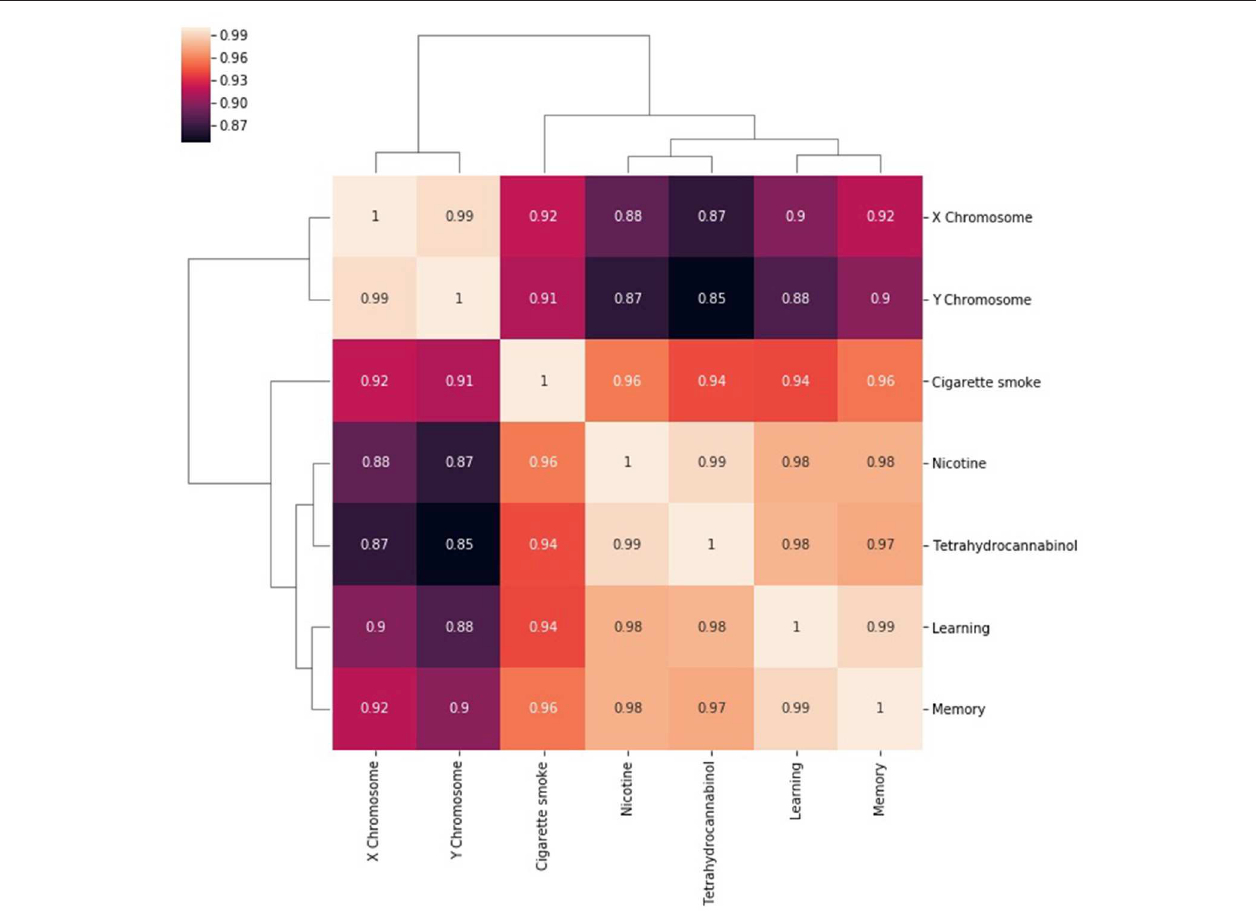
FIGURE 3 | A heatmap of the correlation between the number of metapaths for a given source node with respect to pairs of target nodes. The number of metapaths to the X chromosome target correlates with the number of metapaths to the Y chromosome target, but less so with the other targets. Similar relationships can be seen between nicotine and THC and between learning and memory. Correlations remain generally high because entities that are well researched are likely to be highly connected in